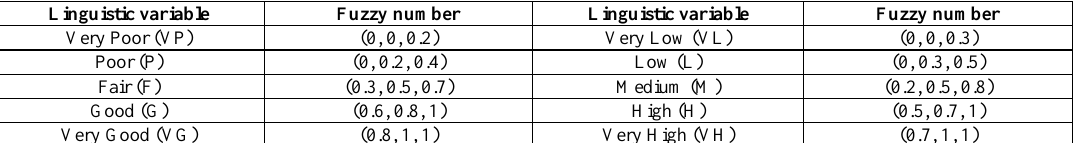
Table 1. Linguistic variables for weights and alternatives